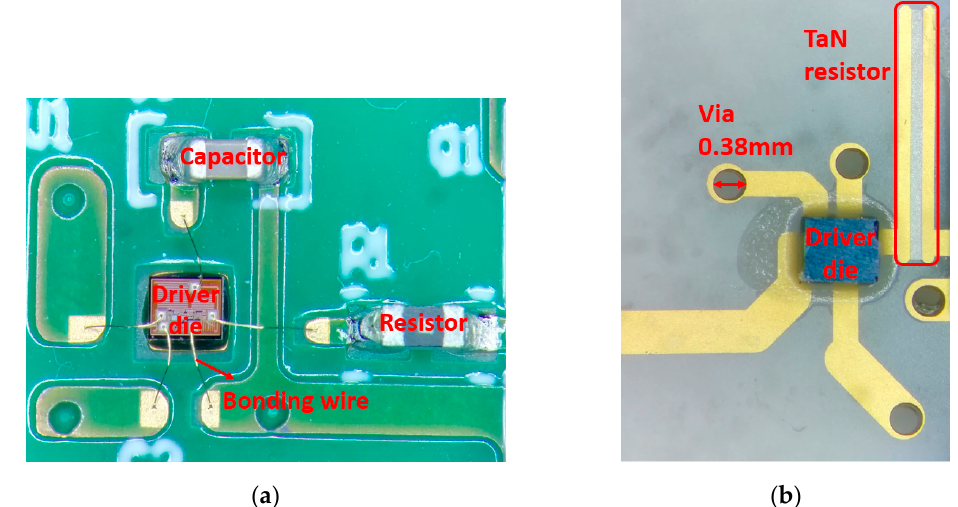
Figure 2. Microscope photograph of the driver loop ( a ) packaged by wire bonding technology; ( b ) packaged by flip-chip technology.